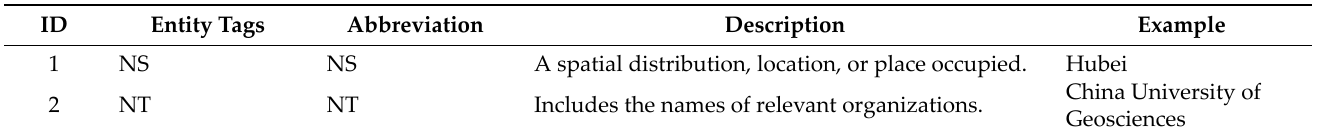
Table 4. Details of entity categories in